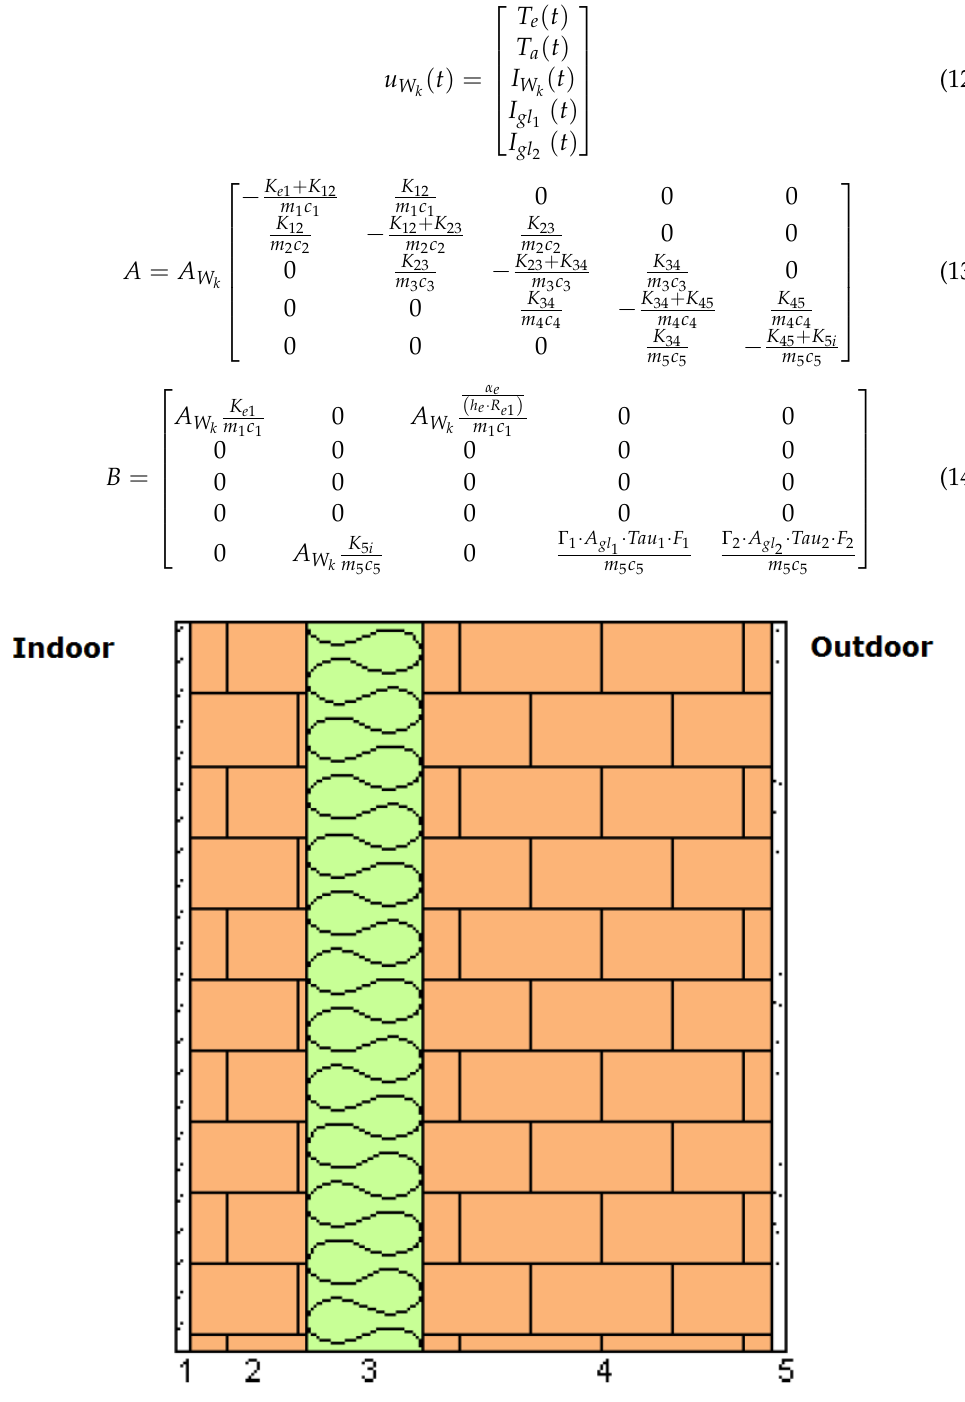
Figure 4. Multi-layer wall [42]. Table 5. Thermal model parameters (Equations (10)–(14)).